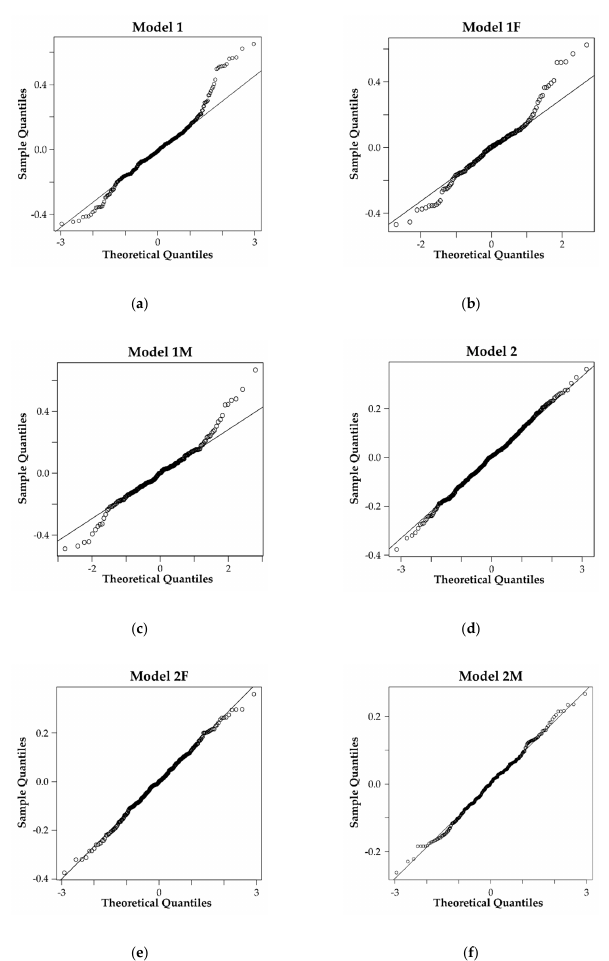
Figure A1. Q-Q plots of residuals of the linear mixed effects models used in this study. Models were calculated for all specimens of Amara alpina ( a —Model 1), females of A. alpina ( b —Model 1F), males of A. alpina ( c —Model 1M), and all specimens ( d —Model 2), females ( e —Model 2F) and males ( f —Model 2M) of Pardosa palustris , respectively. The expected mean of residuals is plotted as a